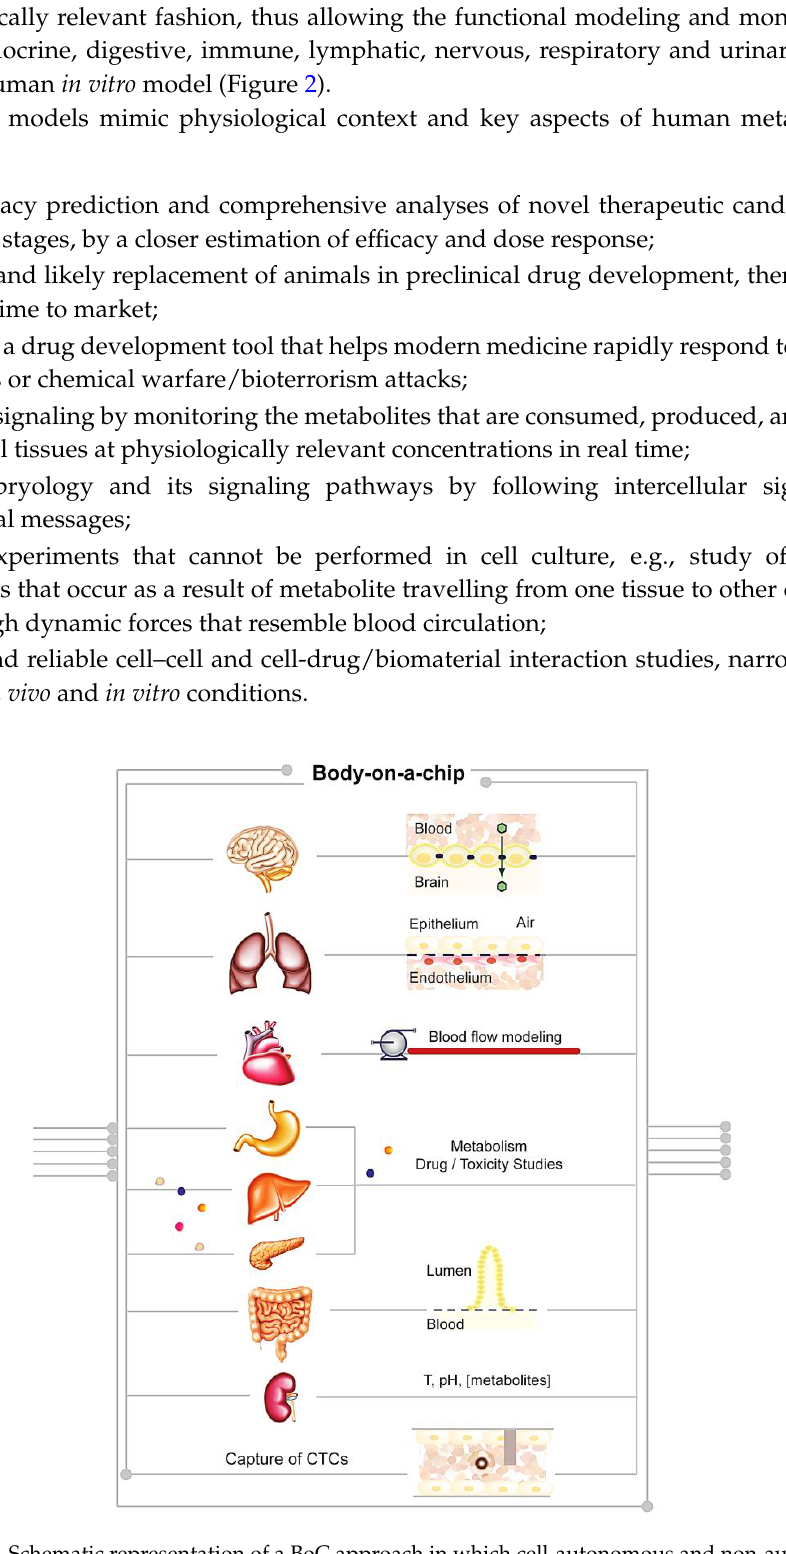
Figure 2. Schematic representation of a BoC approach in which cell-autonomous and non-autonomous studies can be performed using a single chip.